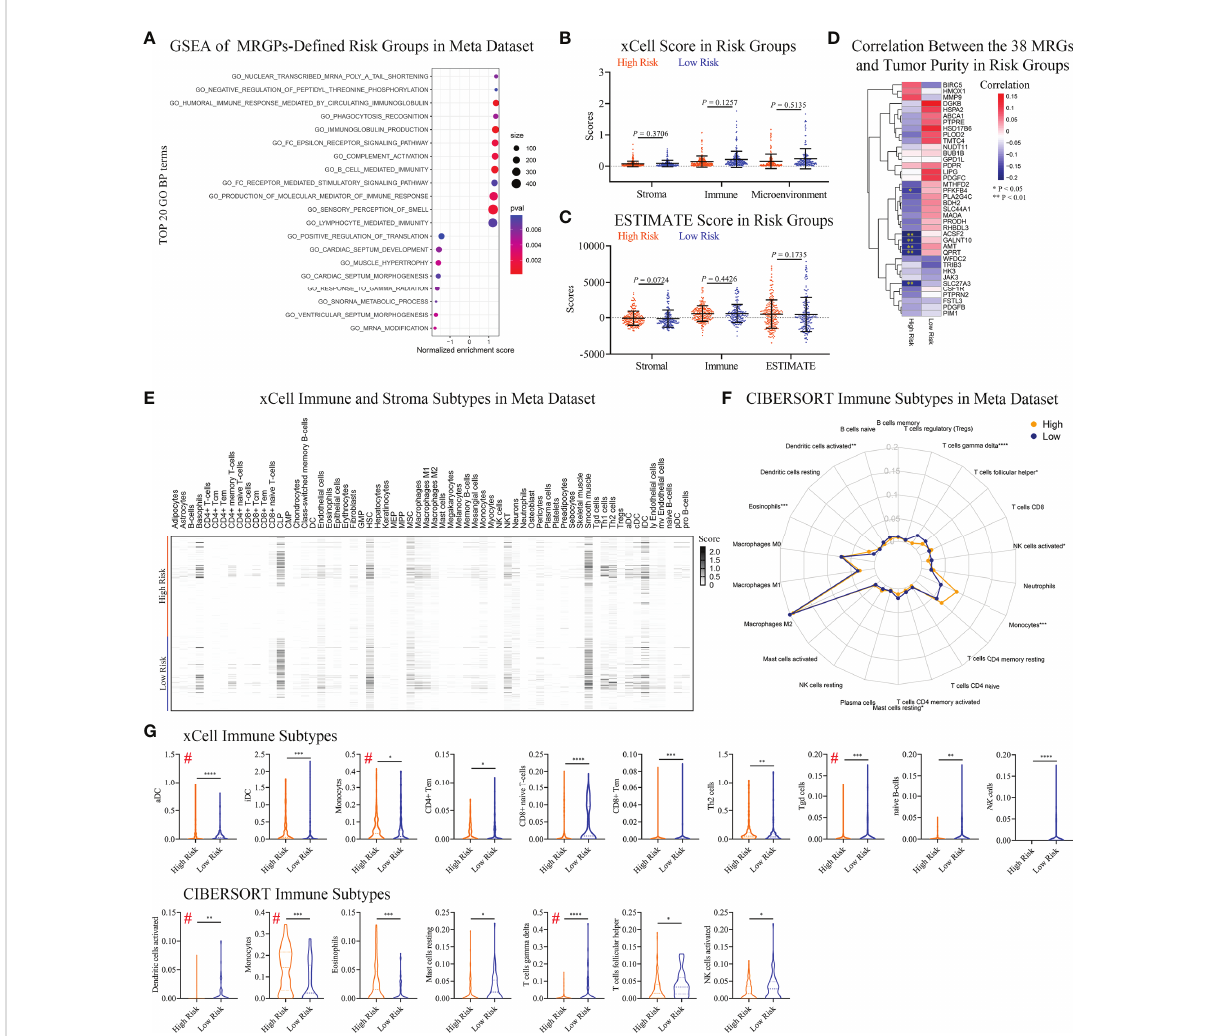
FIGURE 4 Differences in Immune In fi ltration Pro fi les Between Risk Groups De fi ned by Metabolic Signature. (A) GSEA of MRGP risk groups in the meta dataset ( P < 0.05). The top 20 GO biological processes are shown. Multiple GO biological processes related to immunology, including immunoglobulin-mediated responses, were enriched in high-risk patients. (B, C) xCELL (B) and ESTIMATE (C) analyses of tumor purity between MRGP risk groups in the meta dataset. No signi fi cant differences between risk groups were observed (Mann – Whitney test). (D) Pearson correlation heatmaps of the expression of 38 MRGs and tumor purity in the risk groups of the meta-dataset. Value > 0 indicates that gene expression is positively correlated with tumor purity, indicating less immune in fi ltration. * P < 0.05; ** P < 0.01. (E) xCell heatmap of the abundance of 64 immune and stroma cells in IDH WT GBM patients within risk groups in the meta dataset. (F) CIBERSORT analysis of the abundance of 22 immune cells in IDH WT GBM patients within risk groups in the meta dataset. (G) Immune cell subtypes signi fi cantly different between risk groups. Data is related to (E, F) . # indicates the same immune subtype in xCell and CIBERSORT analyses. The difference between risk groups was calculated by the Mann – Whitney test (* P < 0.05, ** P < 0.01, *** P < 0.001, **** P <